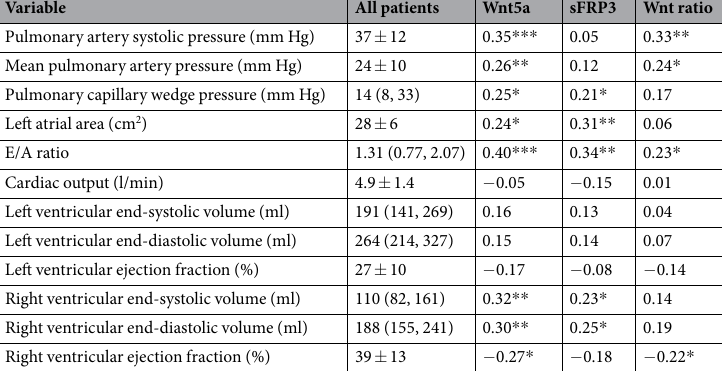
Table 2. Associations between plasma Wnt5a, sFRP3, the Wnt5a/sFRP3 ratio and ventricular function in patients with DCM. Data are given as mean ± standard deviation or median (25 th /75 th percentile) depending